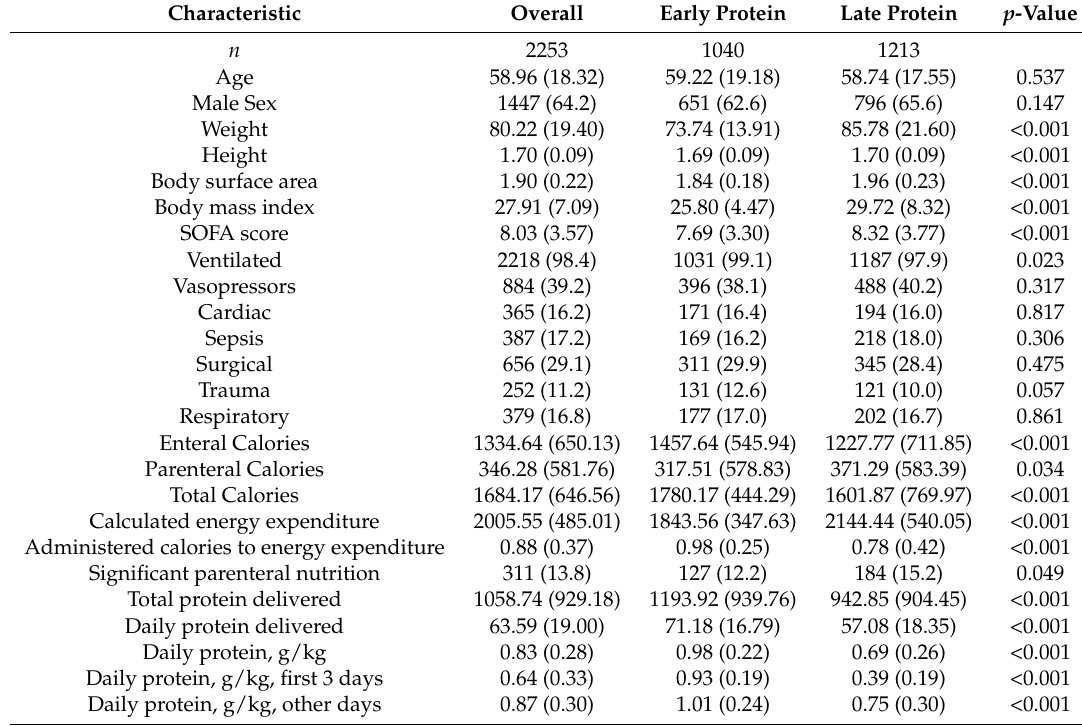
Table 1. Patient Characteristics—Comparison between Early and Late